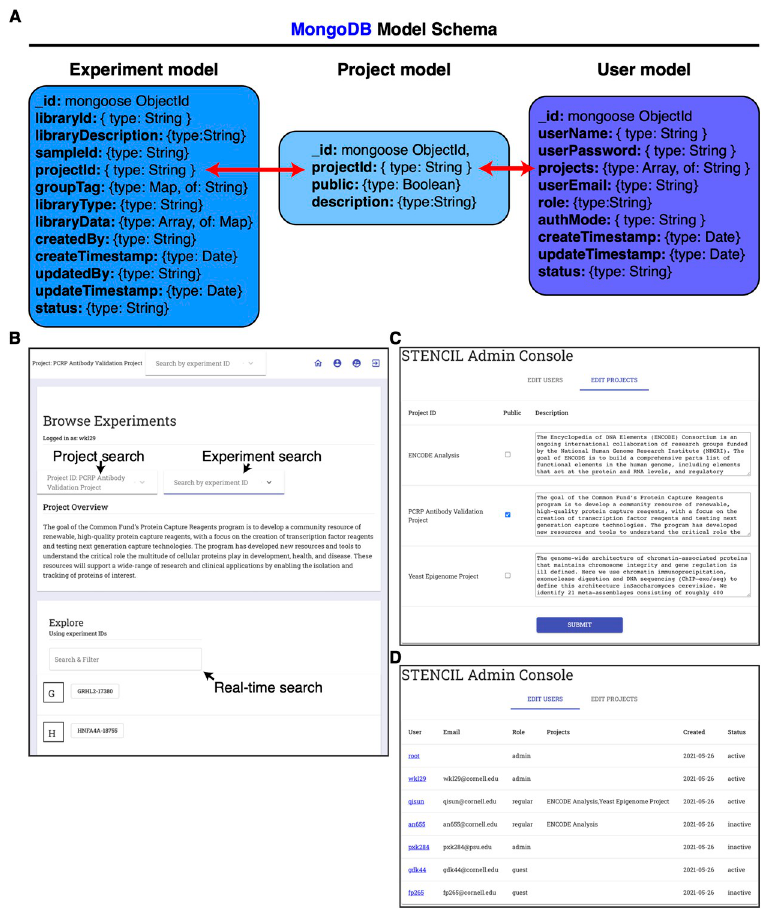
Fig 2. STENCIL backend enables precise project organization and authorization (A) MongoDB model schema of STENCIL backend. URL references to experiment analysis are stored in the Experiment model. Experiments are linked to the Project model through a common projectId string. Users gain access to models and underlying experimental data through assignment to a variable number of projectIds. (B) Experiment navigation screen of STENCIL. STENCIL supports users accessing multiple public and private projects as defined by the backend database. Real-time search enables quick filtering and access of experiments in large projects. (C) STENCIL Admin console is available to STENCIL administrators and allows for project public/private control and project summary edits. (D) STENCIL Admin console provides control of user access to projects and defining user roles.